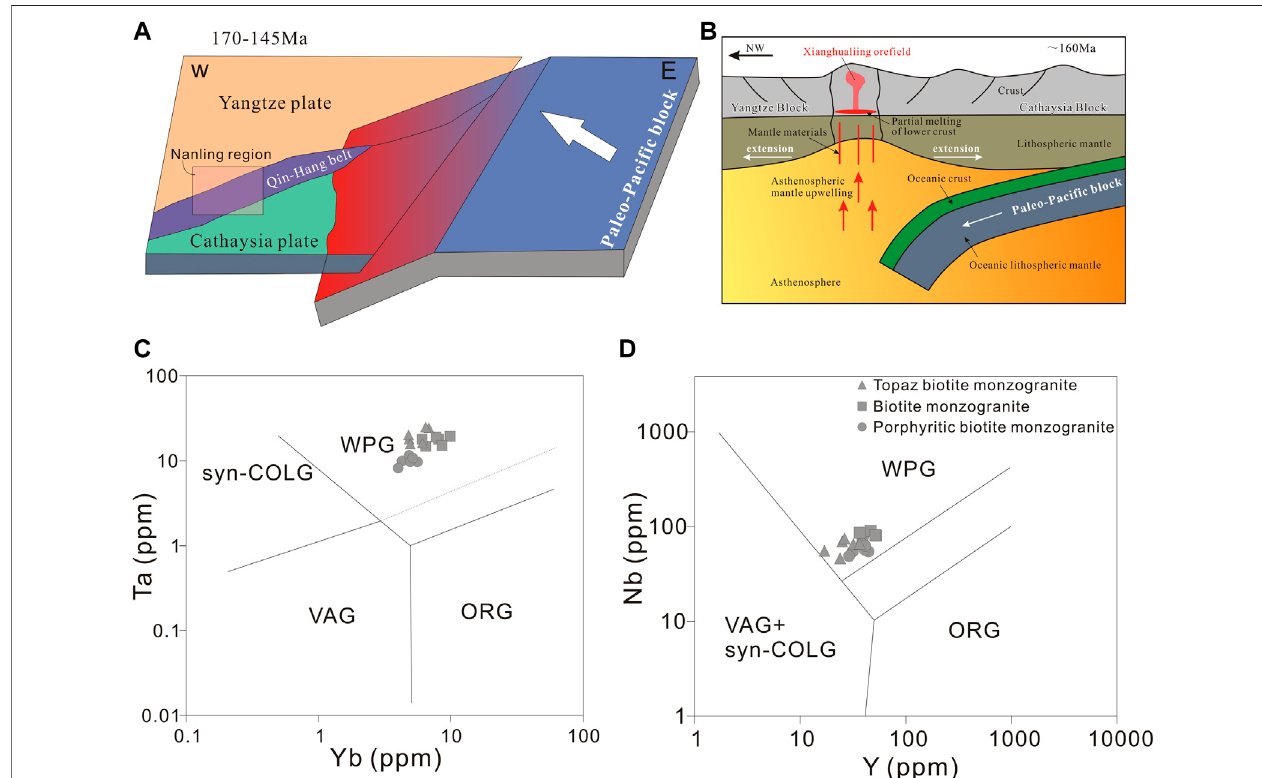
FIGURE 14 | Sketch diagram of the deep dynamic evolution of the Mesozoic metallogenesis of the Xianghualing ore fi eld (A,B) . Discrimination diagrams of granite type and tectonic setting for the Jianfengling granitic rocks: (C) Y vs Nb; and (D) Yb vs Ta. Base maps after Pearce (1996).